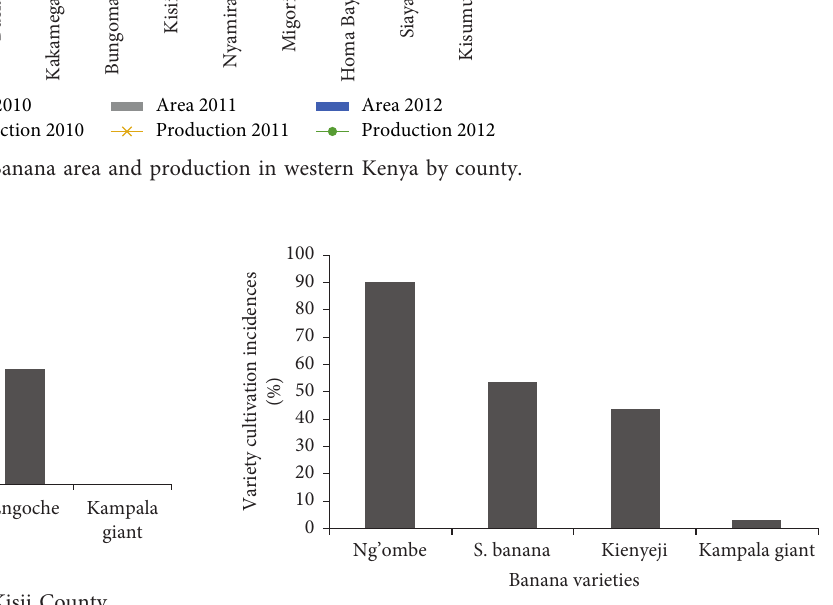
Figure 8: Local banana varieties in Nyamira